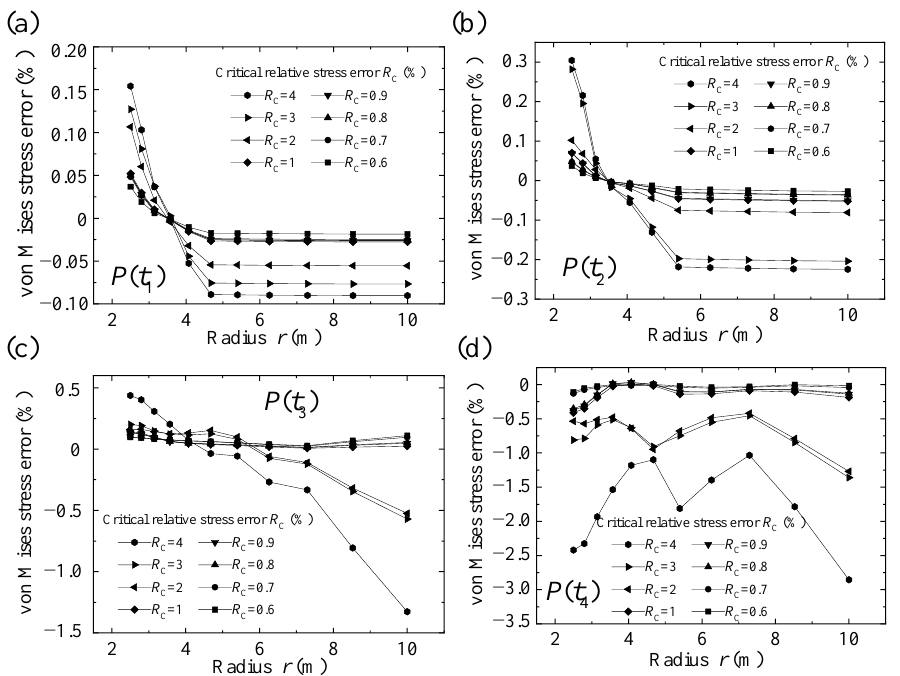
Figure 6. The relative stress errors along the radius of the thick wall cylinder on four turning points of cyclic loading with different critical relative energy error R C : ( a ) P ( t 1 ), ( b ) P ( t 2 ), ( c ) P ( t 3 ), and ( d ) P ( t 4 ).